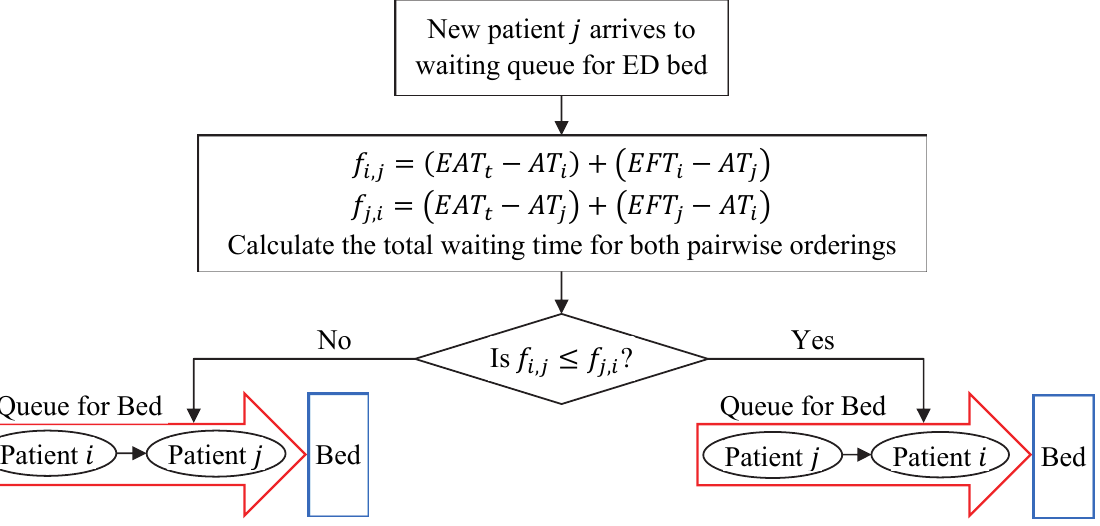
Fig. 3. Describe the BPF algorithm by using a simple example (one bed and two patients)